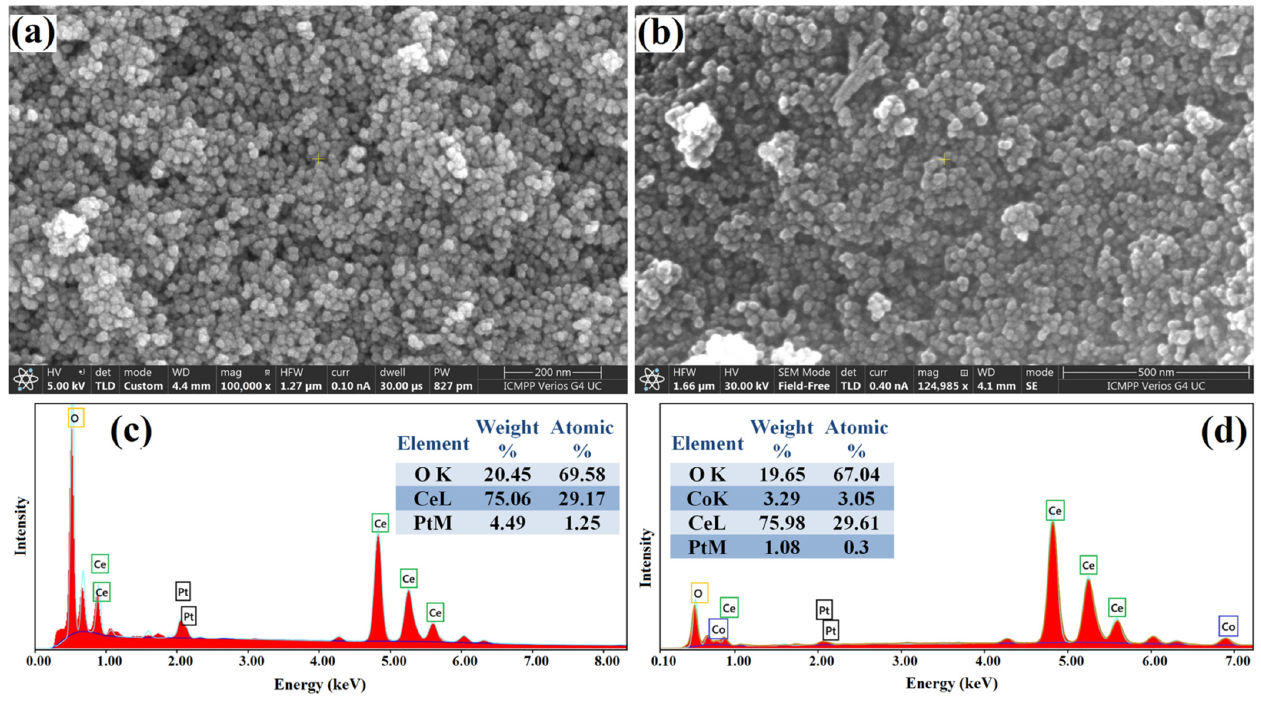
Figure 3. SEM images of V2 ( a ) and V2-Co ( b ) samples and EDX elemental analysis spectra of V2 ( c ) and V2-Co ( d ).